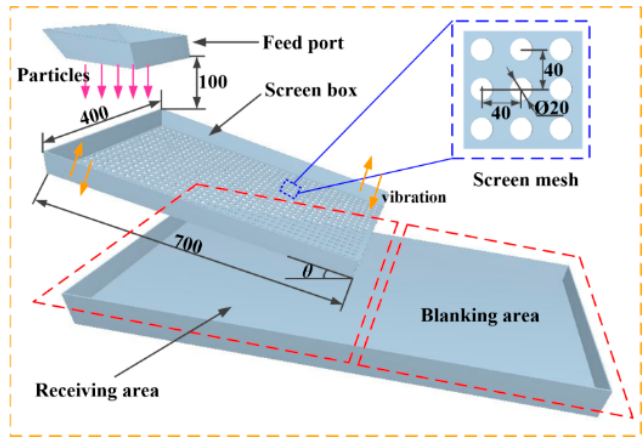
Figure 5. Discrete element model for the vibration screen (dimensions shown in mm). Table 3. Geometric parameters in the vibration screen model. Parameters